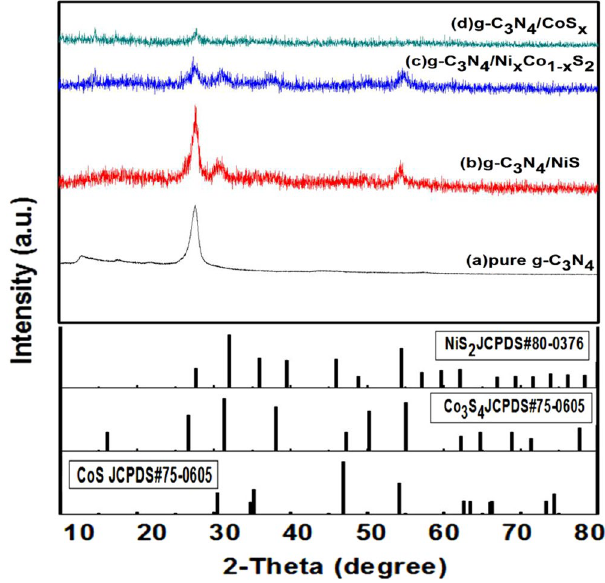
Figure 1. X-ray diffraction (XRD) patterns of pure g-C 3 N 4 , g-C 3 N 4 /NiS 2 , g-C 3 N 4 /CoS x and g-C 3 N 4 /Ni x Co 1 − x S 2 and the JCPDS of NiS 2 , Co 3 S 4 and CoS.